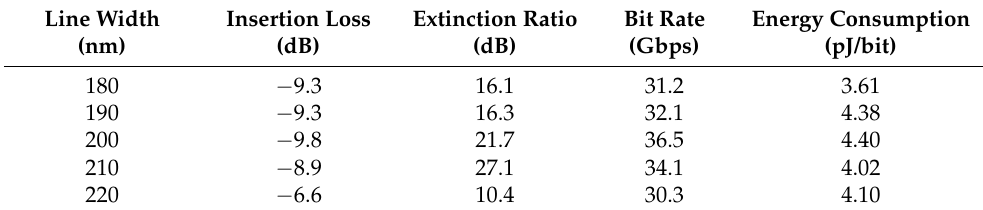
Table 2. The performance of CIPMRMs for different line